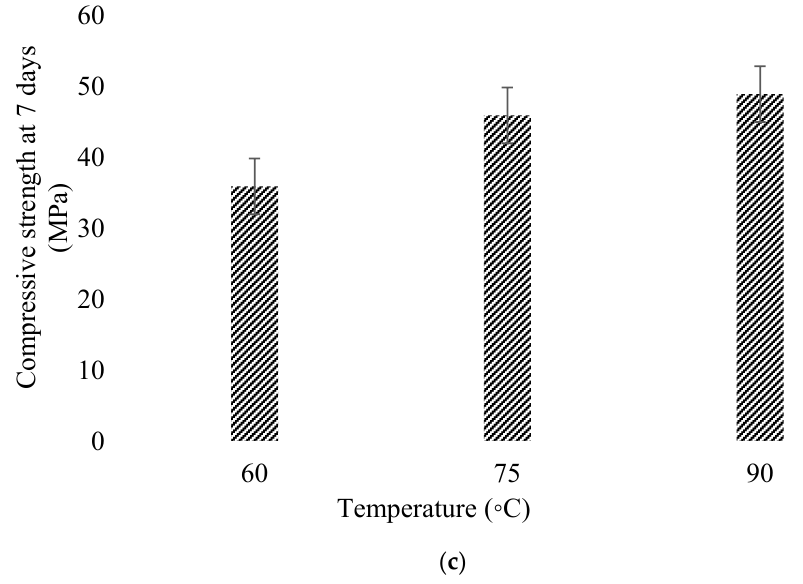
Figure 13. Effect of early compressive strength on: ( a ) Na 2 SiO 3 /NaOH ratio, ( b ) alkaline liquid/FA Figure 13. E ff ect of early compressive strength on: ( a ) Na 2 SiO 3 / NaOH ratio, ( b ) alkaline liquid / FA ratio, ( c ) curing temperature, modified from [135]; Springer, 2019. ratio, ( c ) curing temperature, modified from [135]; Springer, 2019.